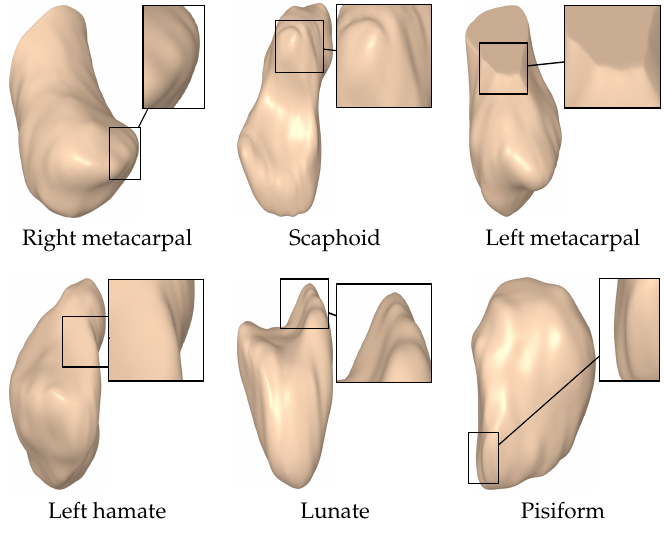
Figure 5. Carpal bone